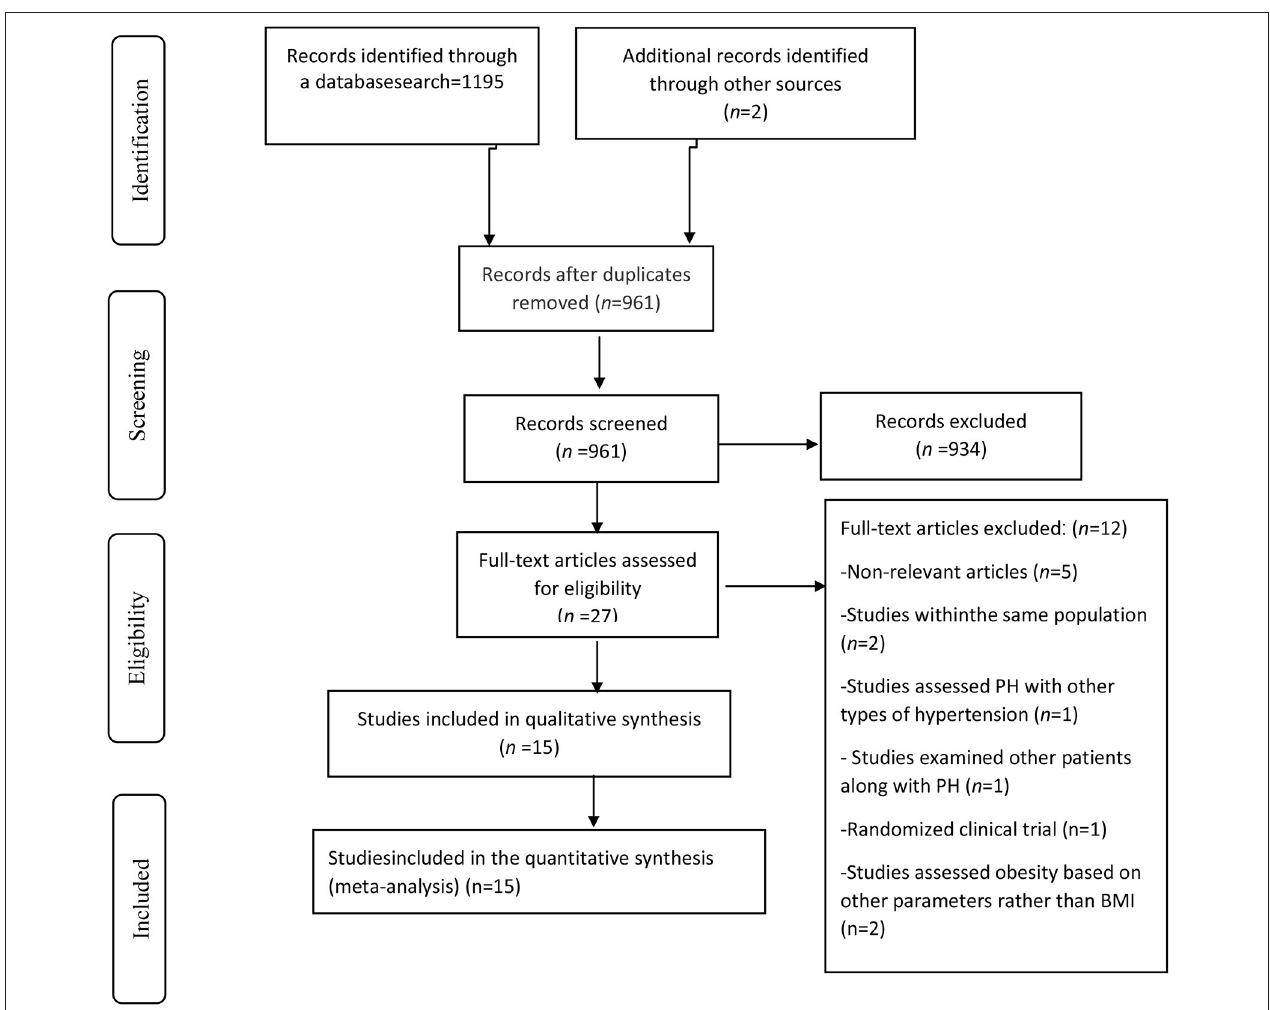
FIGURE 1 | Study selection flow